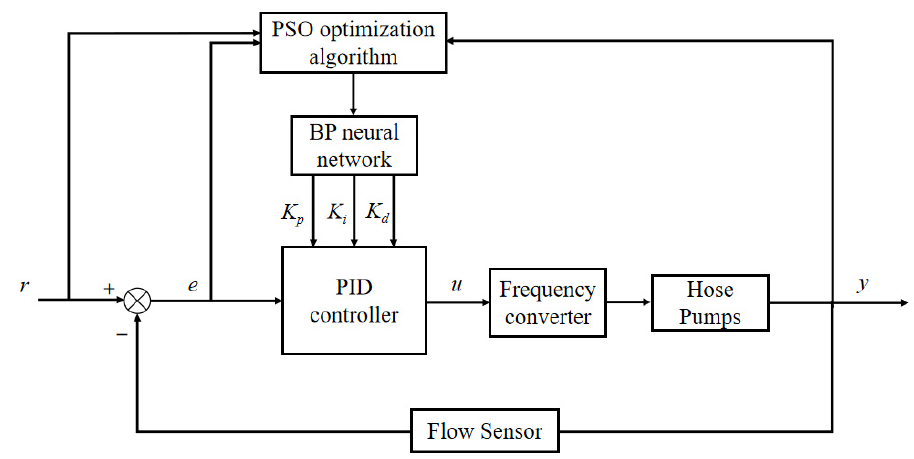
Figure 6. Structure of BP neural network PID controller based on PSO optimization.